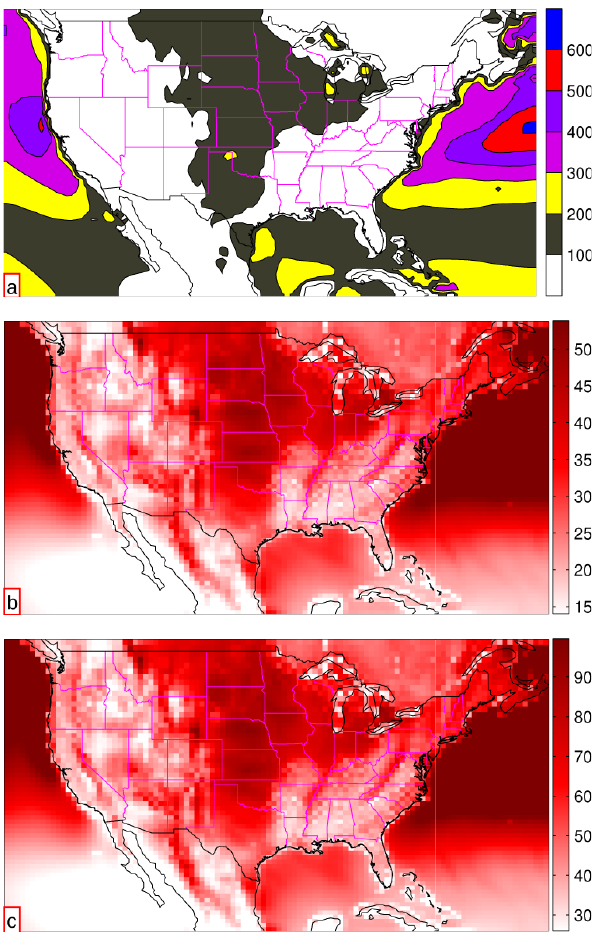
Fig. 12. Variation of median WPD (W m − 2 ) at different heights. (a) shows the median wind power at 80m and, (b) and (c) show the difference median WPD at 100m and 120m from that at 80m.